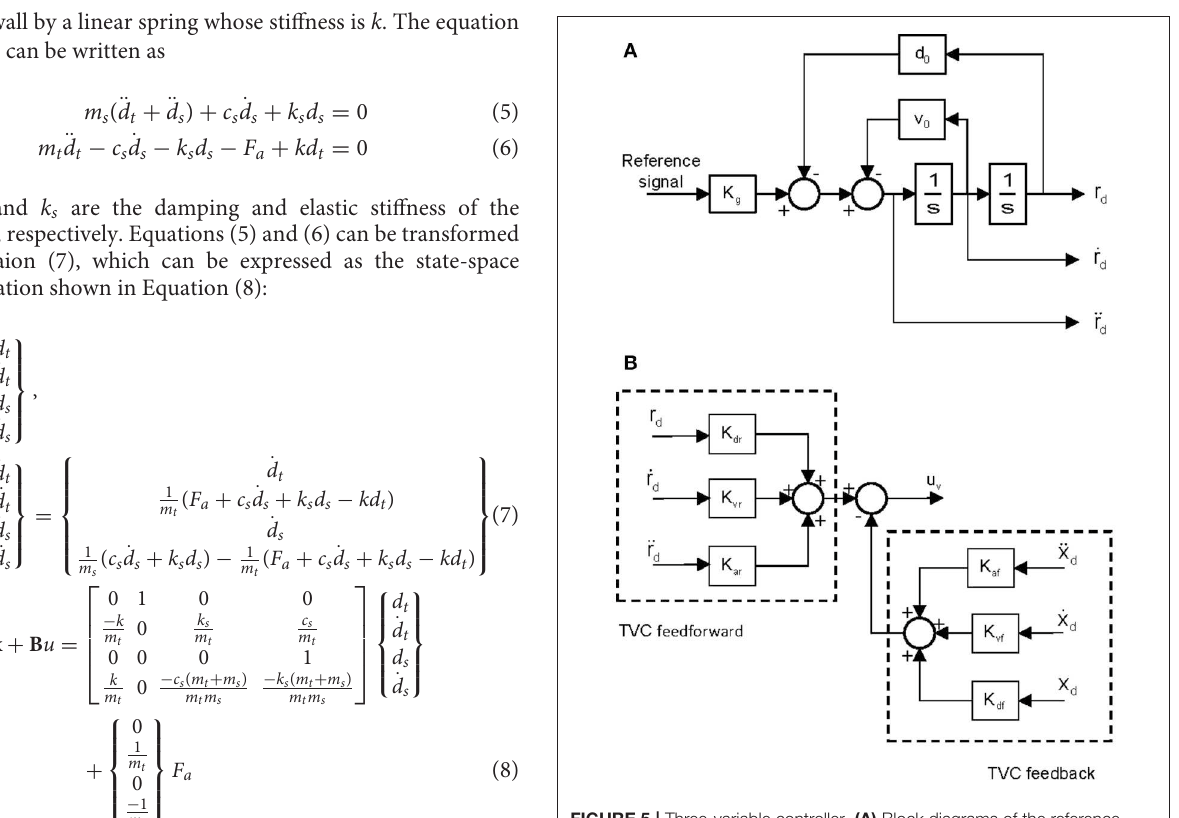
FIGURE 5 | Three-variable controller. (A) Block diagrams of the reference signal generator. (B) Block diagrams of TVC controller.